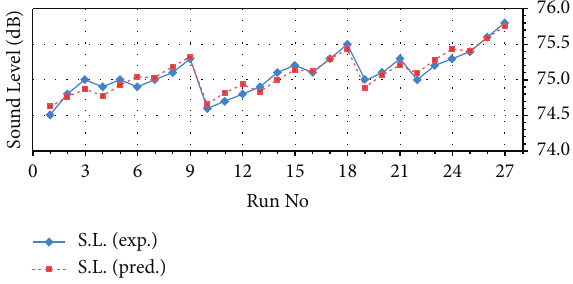
Figure 9: Comparison between predicted and measured values for sound intensity